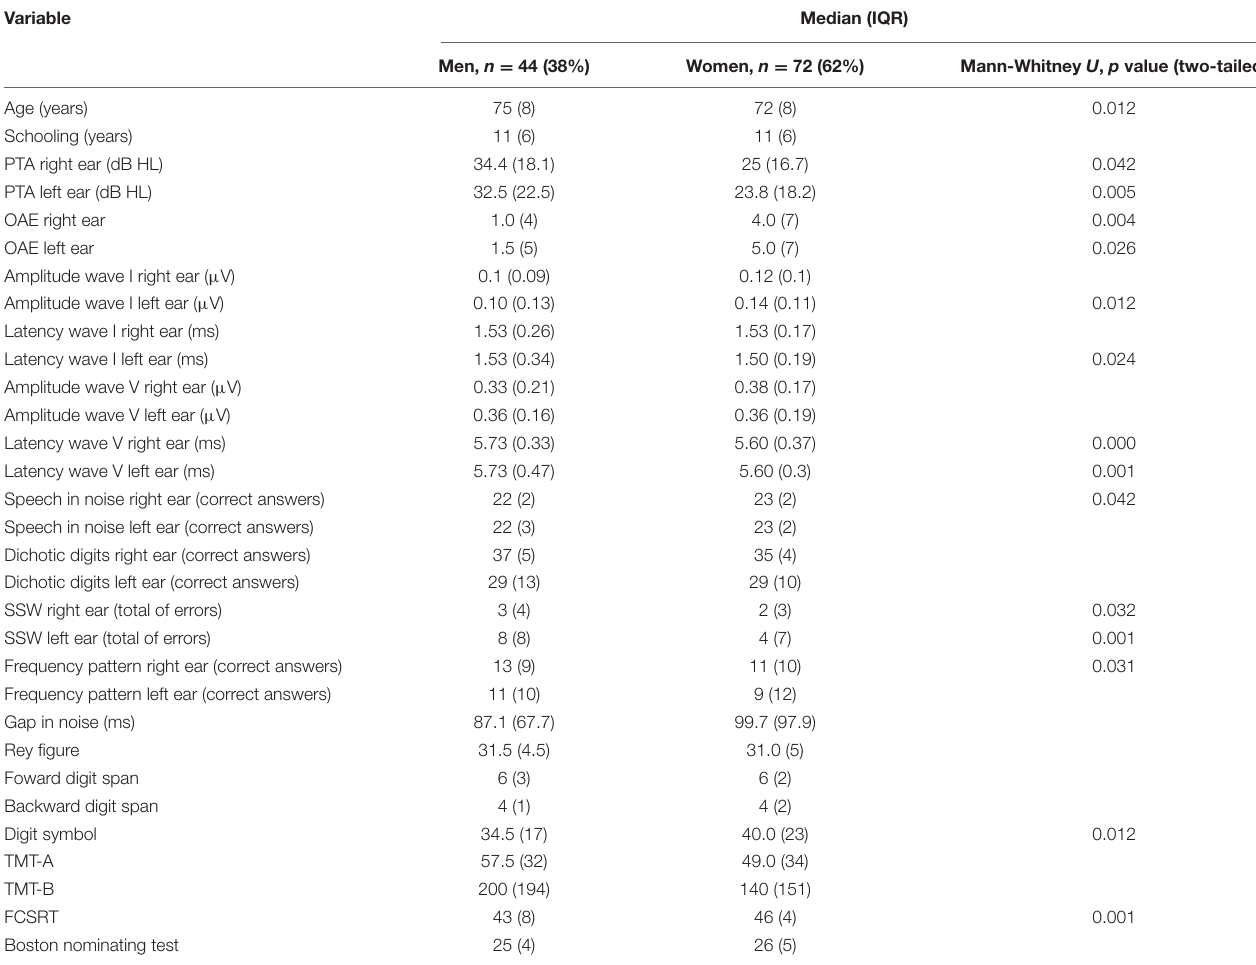
TABLE 1 | Description (mean and SD) of variables, including demographics (age and schooling), hearing loss, suprathreshold auditory brain stem responses, auditory processes, and cognitive domains.